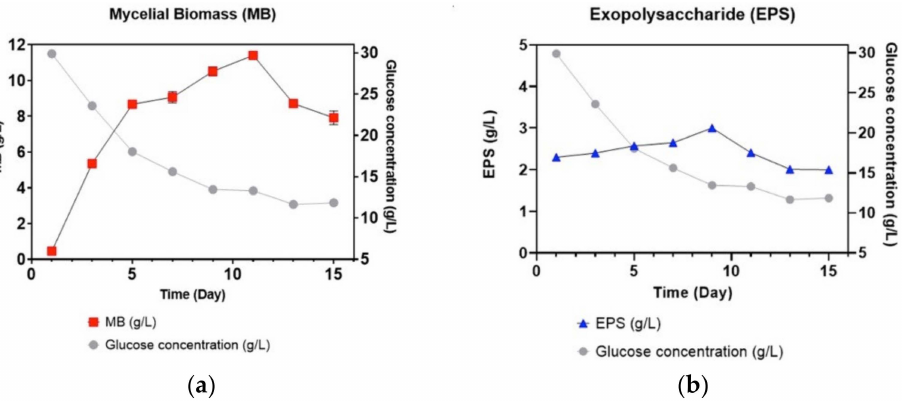
Figure 2. Growth curve and glucose consumption analyses for ( a ) MB and ( b ) EPS of L. rhinocerus strain ABI in shake flask